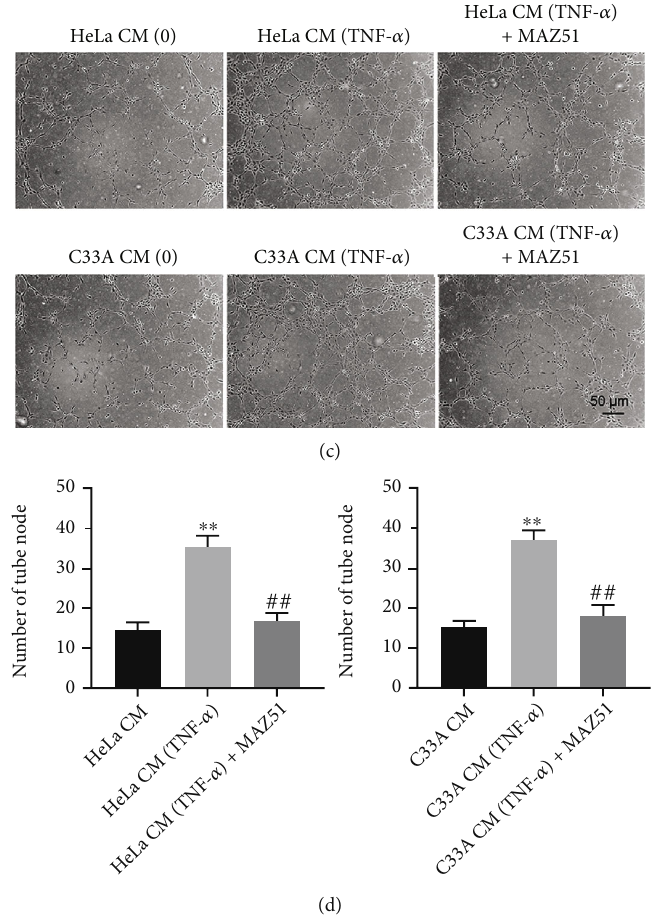
Figure 2: CM-TNF- α promotes the proliferation and angiogenesis of HLECs. Cervical cancer cells (HeLa and C33A) were stimulated with 10ng/ml TNF- α for 48h, and corresponding CM was collected. Next, HLECs were cultured in CM with or without MAZ51 treatment. (a, b) The proliferation of HLECs was measured by EdU staining assay. (c, d) The number of tube node of HLECs was observed using a microscope. ∗∗ P < 0 : 01 compared with CM group; ## P < 0 : 01 compared with CM-TNF- α group, n = 3